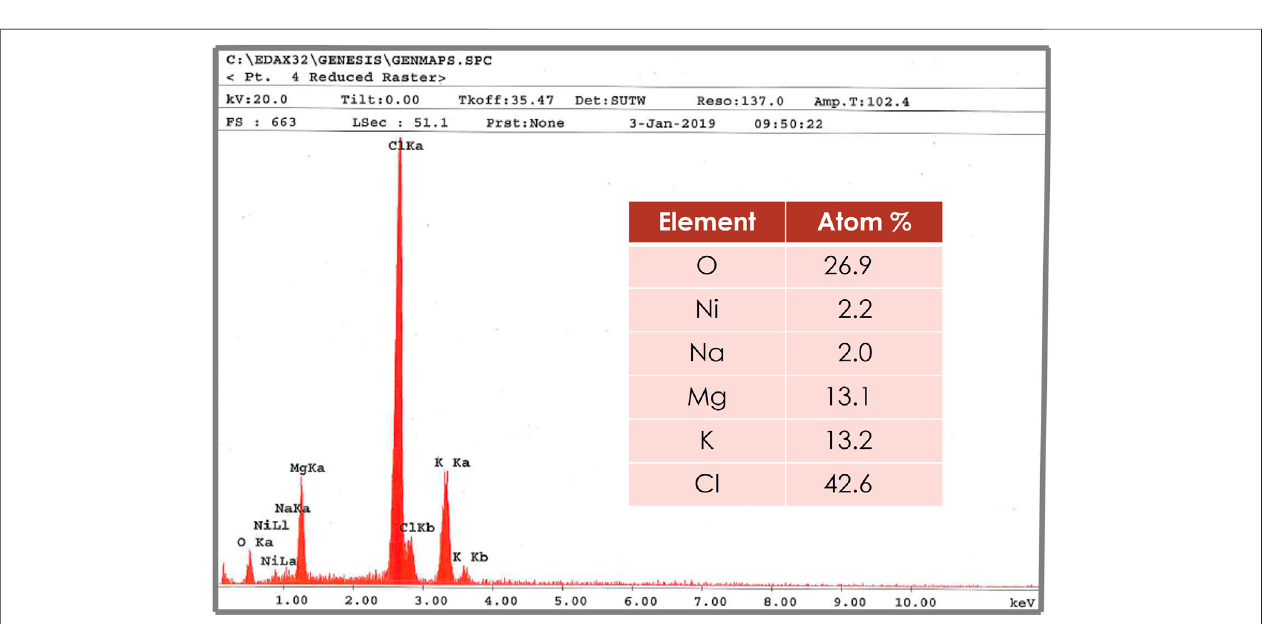
FIGURE 4 | SEM analysis of puri fi ed salt showing the main elements including potassium, magnesium, and sodium chlorides. Some oxygen was observed, which was further quanti fi ed by titration.